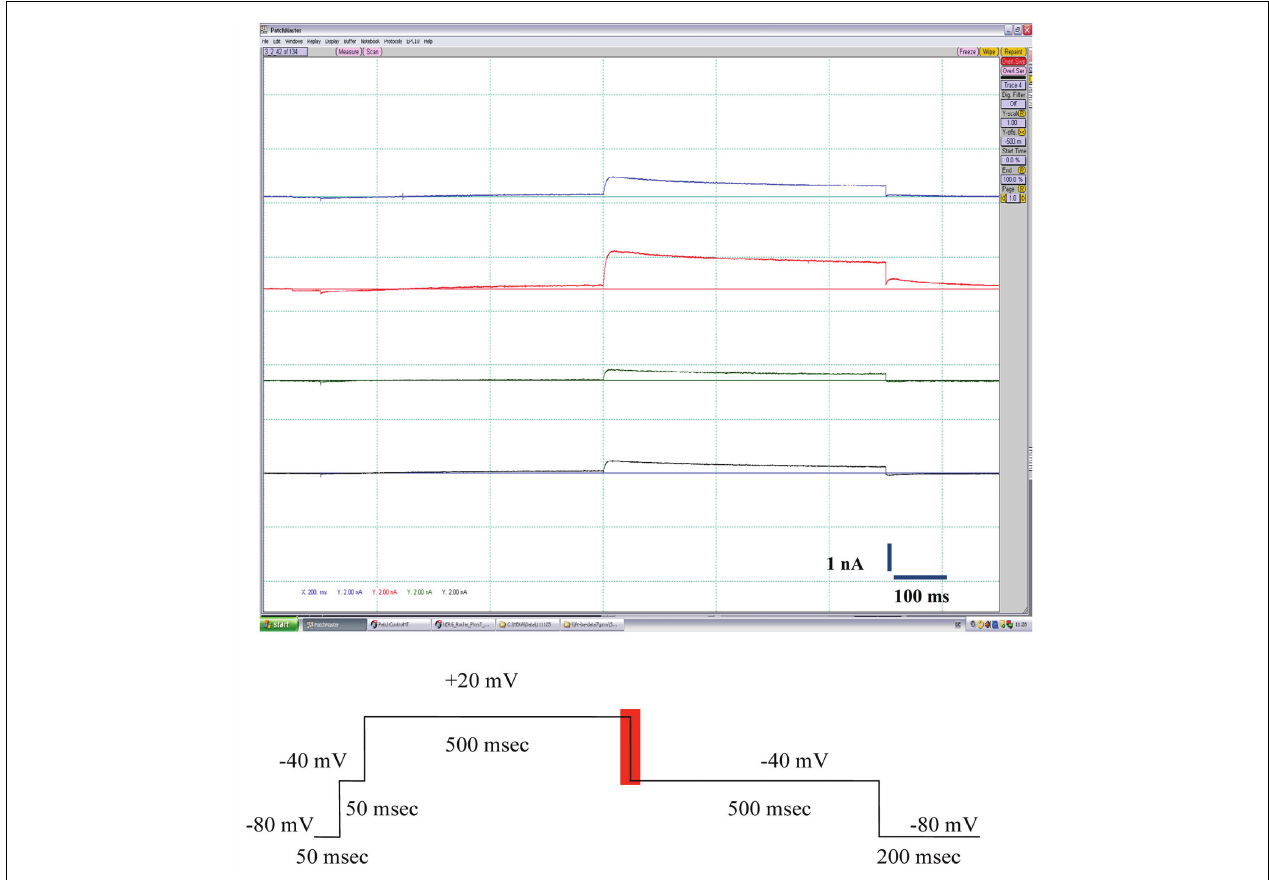
FIGURE 2 |The top panel shows typical outward K + current traces elicited in CHO-hERG cells by the voltage pulse depicted at the bottom panel (the area for the peak current measurement is highlighted in red).